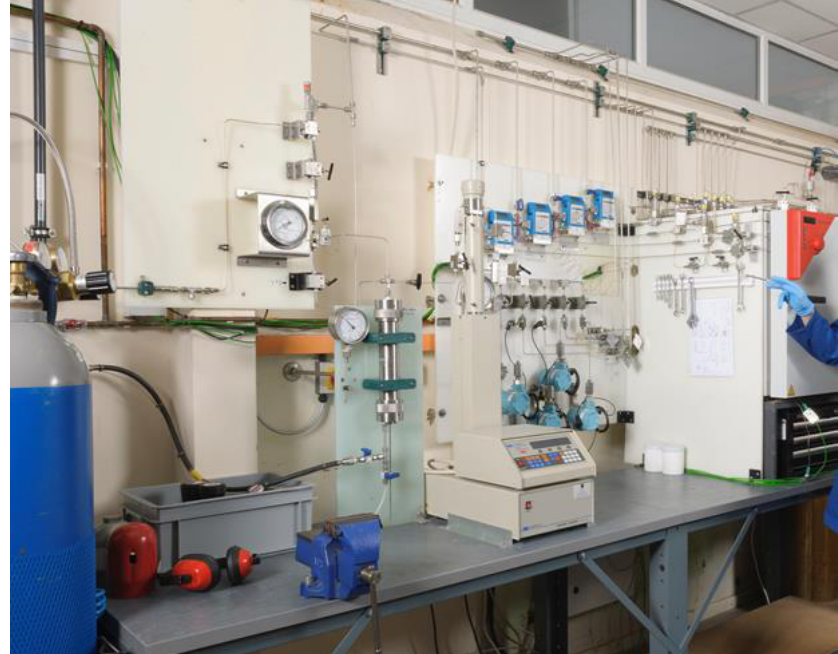
Figure 1. The custom-built rig used to expose polymers to supercritical CO 2 mixtures at pressures up to 689 barg.